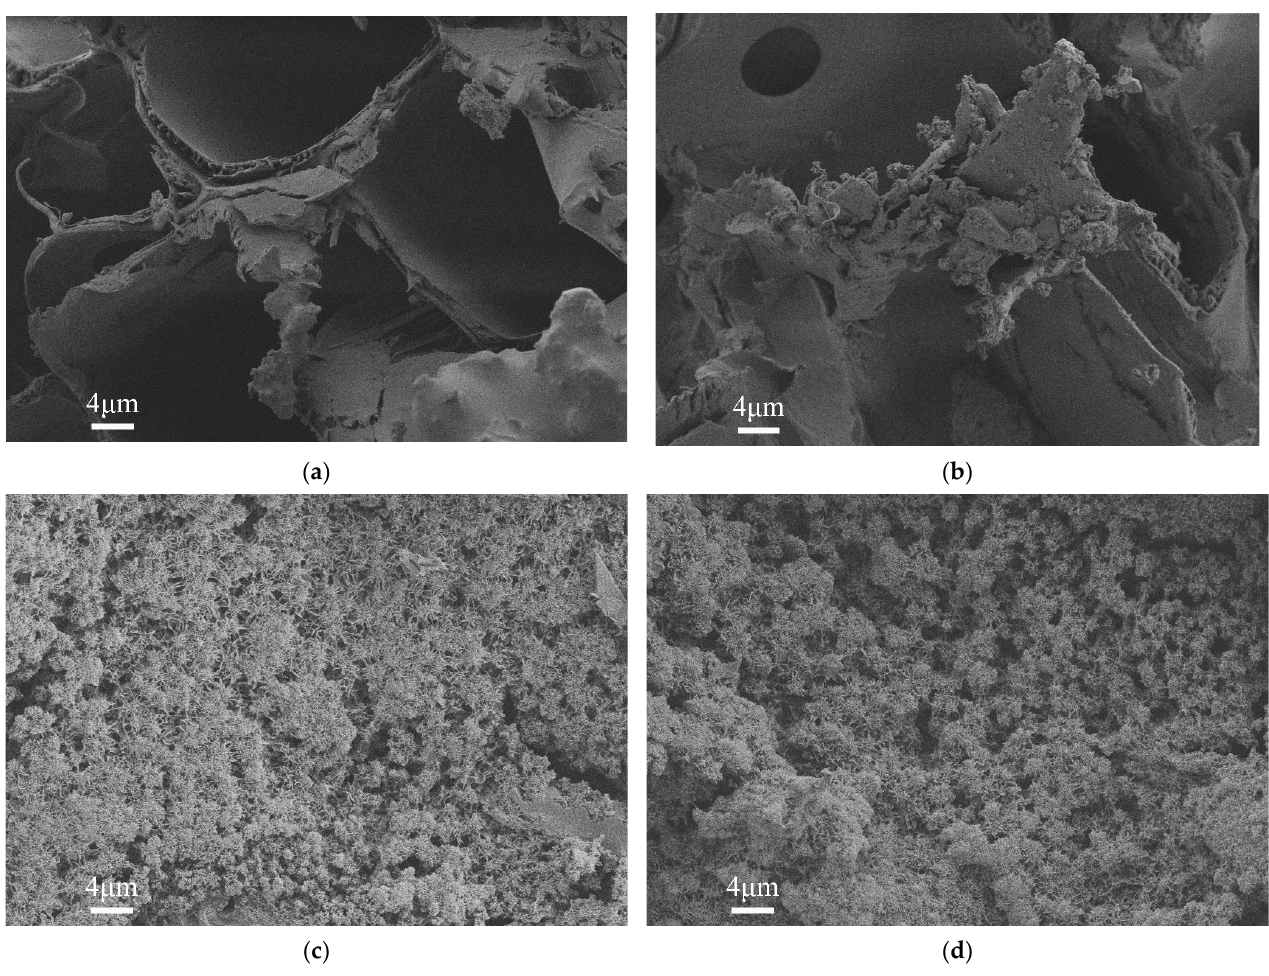
Figure 4. SEM images of the wood samples at 2000 × magnification: ( a ) Untreated; ( b ) 1 cycle treatment; ( c ) 5 cycles treatment; ( d ) 10 cycles treatment.